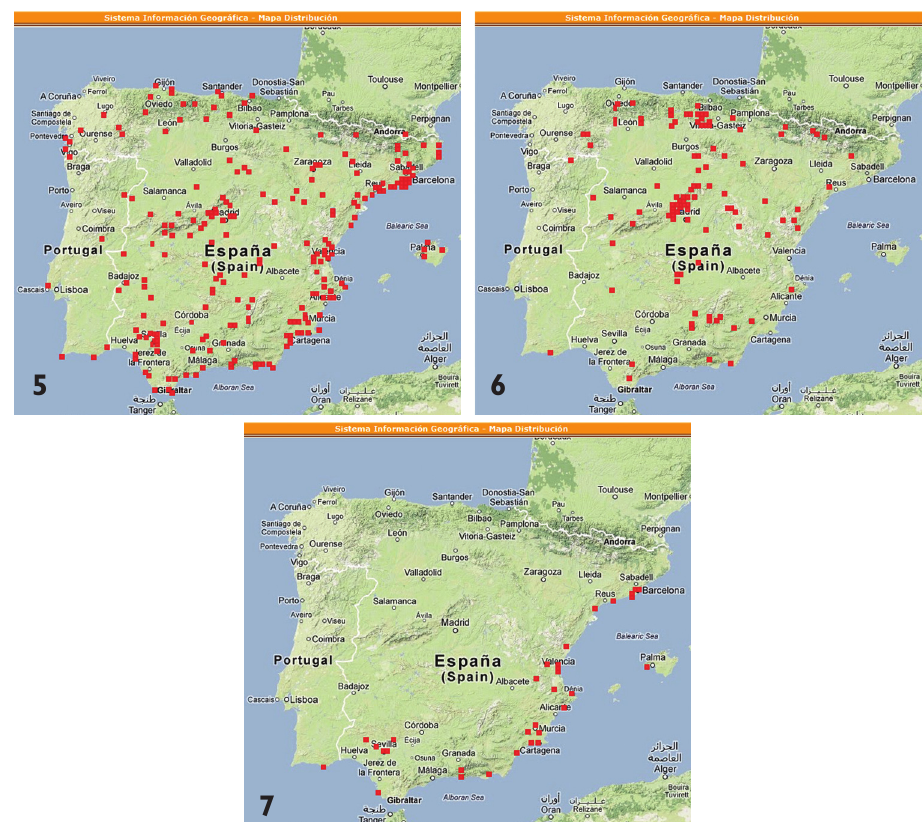
Figures 5–7. 5 Spilostethus pandurus (Scopoli, 1763)(Lygaeidae, Lygaeinae) 6 Spilostethus saxatilis (Sco- poli, 1763) (Lygaeidae, Lygaeinae) 7 Spilostethus furcula (Herrich-Schaeffer, 1850) (Lygaeidae, Lygaeinae) citations according to retrieved information from 399 pictures hosted at Biodiversidad Virtual internet photosharing